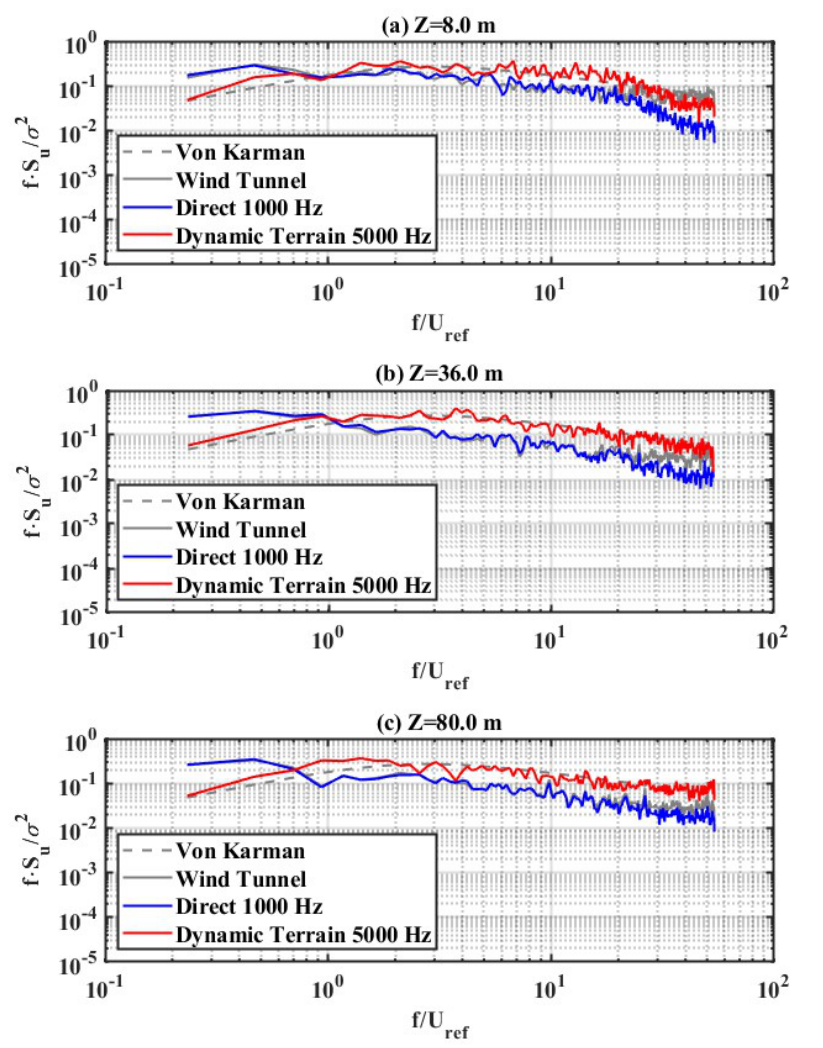
Figure 13. Spectrum of longitudinal velocity from von Karman, as extracted from wind tunnel and calculated from dynamic terrain 5000 Hz and direct method at